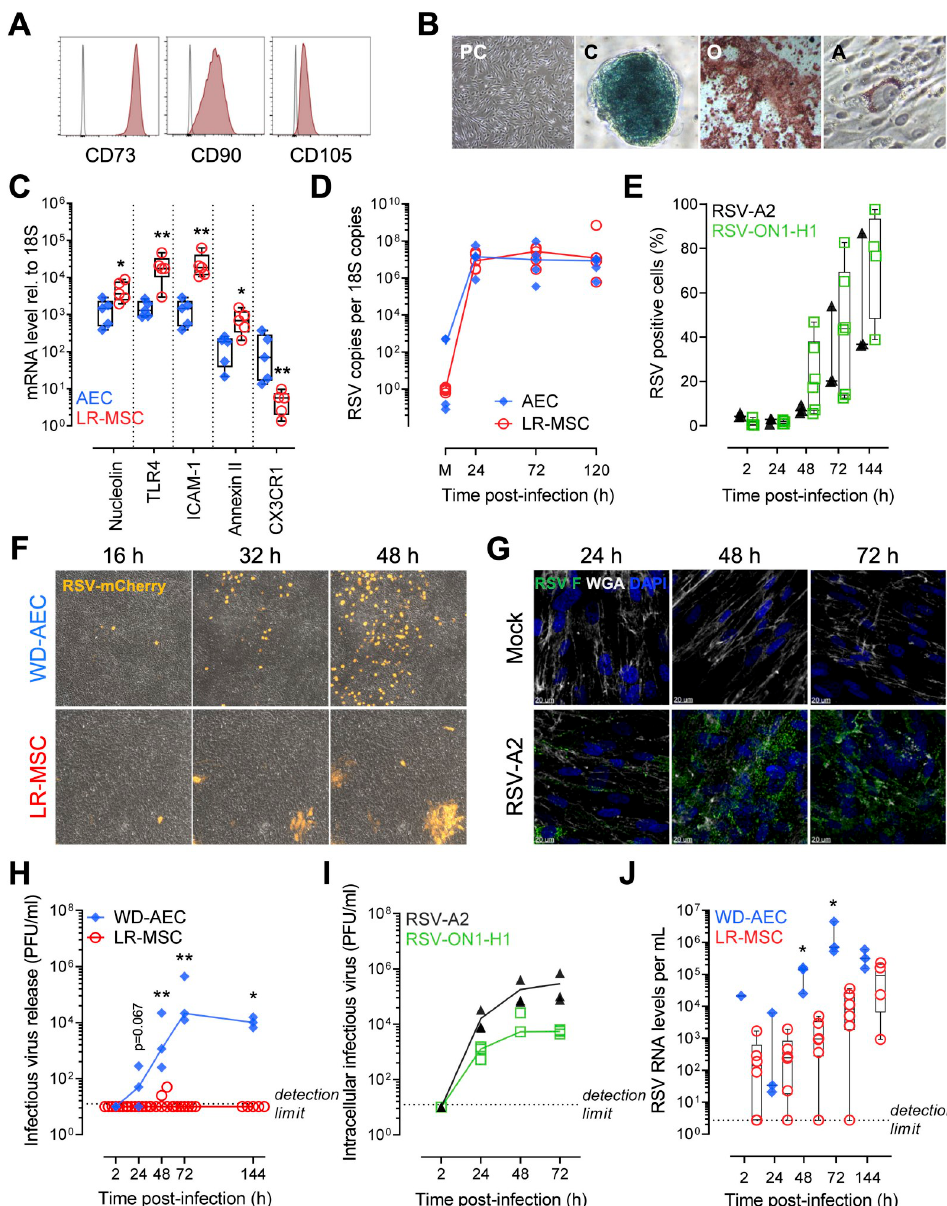
Fig 1. LR-MSCs are highly permissive to RSV infection. (A) Representative histograms showing expression of the surface markers CD73, CD90, CD105 on pediatric LR-MSCs. (B) Representative phase-contrast (PC) micrograph showing morphology in culture and demonstrates plastic adherence. Representative images of Toluidine blue, Alizarin Red S, and Oil Red O stainings after chondrogenic (C), osteogenic (O), and adipogenic (A) differentiation, respectively. Magnification 40X (PC, O) and 200X (C, A). (C) mRNA expression levels of RSV receptors relative to 10 6 18S. A Mann- Whitney U test was applied to compare the two cell types (AECs versus LR-MSCs). Boxplots indicate the median value (centerline) and interquartile ranges (box edges), with whiskers extending to the lowest and the highest values. Each symbol represents an individual donor (n = 5). � p < 0.05, �� p < 0.01. (D) Intracellular viral loads in AECs and LR-MSCs over time following infection with RSV-A2 at a MOI of 1 PFU/cell expressed as RSV copies per 10 12 18S copies. Each symbol represents an individual donor (n = 5). (E) RSV F-protein positive LR-MSCs assessed by FCM and plotted over time. LR-MSCs were infected with 0.1 PFU/cell with RSV-A2 (n = 3) or a clinical isolate RSV-ON1-H1 (n = 4–6). Each symbol represents an individual donor. (F) Representative live-cell imaging of WD-AECs and LR-MSCs infected with 0.1–0.5 PFU/cell with RSV-mCherry and followed over time. The micrographs were taken at 16, 32, and 48 h p.i. in the same area of the cellular layer. (G) Representative confocal microscopy evaluation of LR-MSCs noninfected (mock) or infected with RSV-A2 at 1 PFU/cell 24 to 72 hours p.i. RSV, green; DAPI, dark blue; WGA, white. Scale bar, 20 μ m. (H)